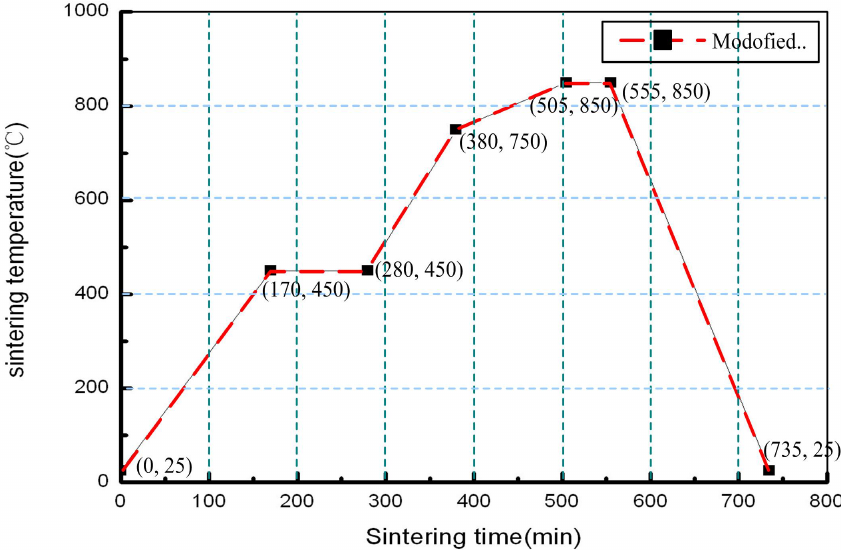
Figure 6. Temperature process control